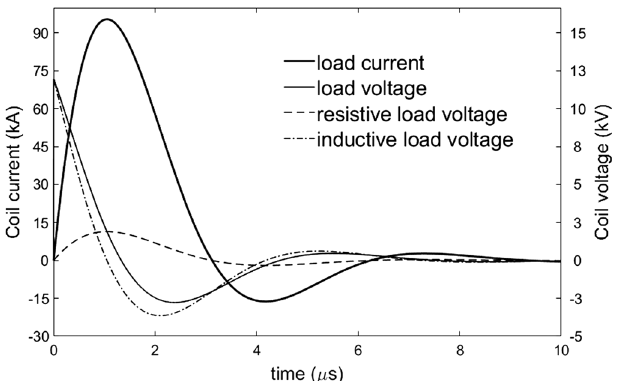
FIG. 3. Simulations of the current and voltage waveforms into a matched 60-nH coil are shown. The thick solid line is the total load current, the thin solid line is the load total load voltage, the dashed line is the load resistive voltage, and the dot-dashed line is the load inductive